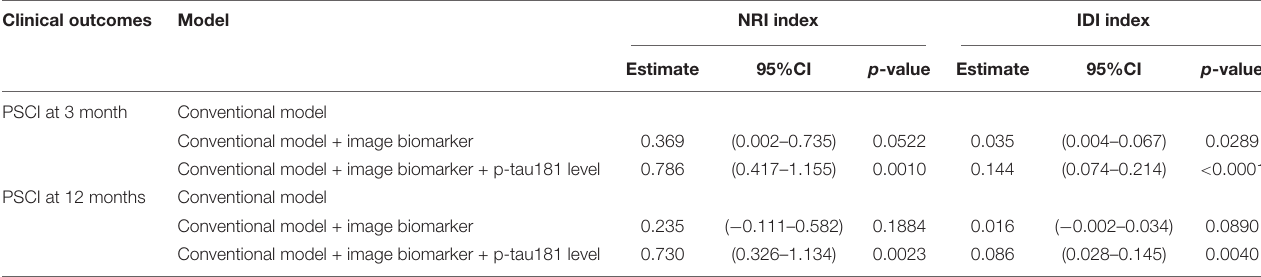
TABLE 3 | Discrimination and reclassification statistics of p-tau181 level for patients with PSCI at 3 and 12 months, respectively. Clinical outcomes